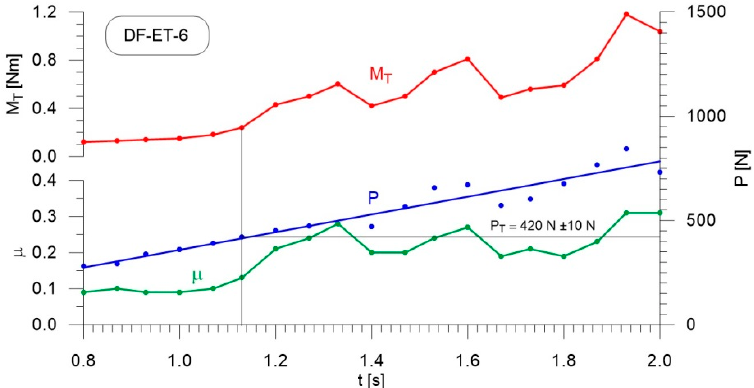
Figure 6. Courses of the load, P, the friction torque, M T , and the friction coefficient, µ for diesel– ethanol blend with a 4% ethanol volume fraction.